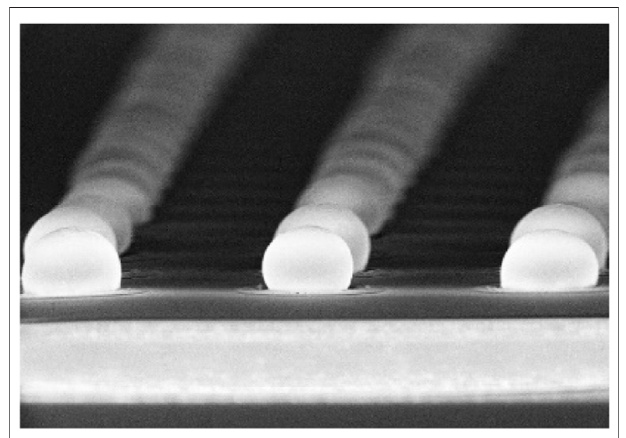
FIGURE 3 | The In bump after re fl ow.